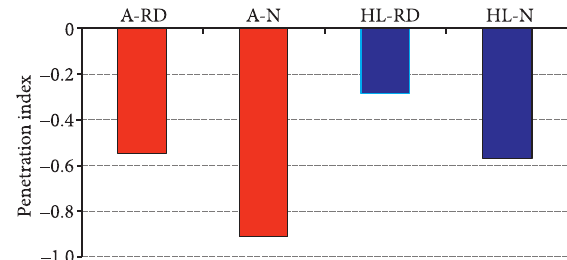
Fig. 2. Changes in penetration indexes of SMA-recovered bitumen Table 1. The evaluation of significant influence of tested factors on the breaking point temperature of the extracted bitumen Univariate results for each DV over-parameterized model type III decomposition Effect Degr.